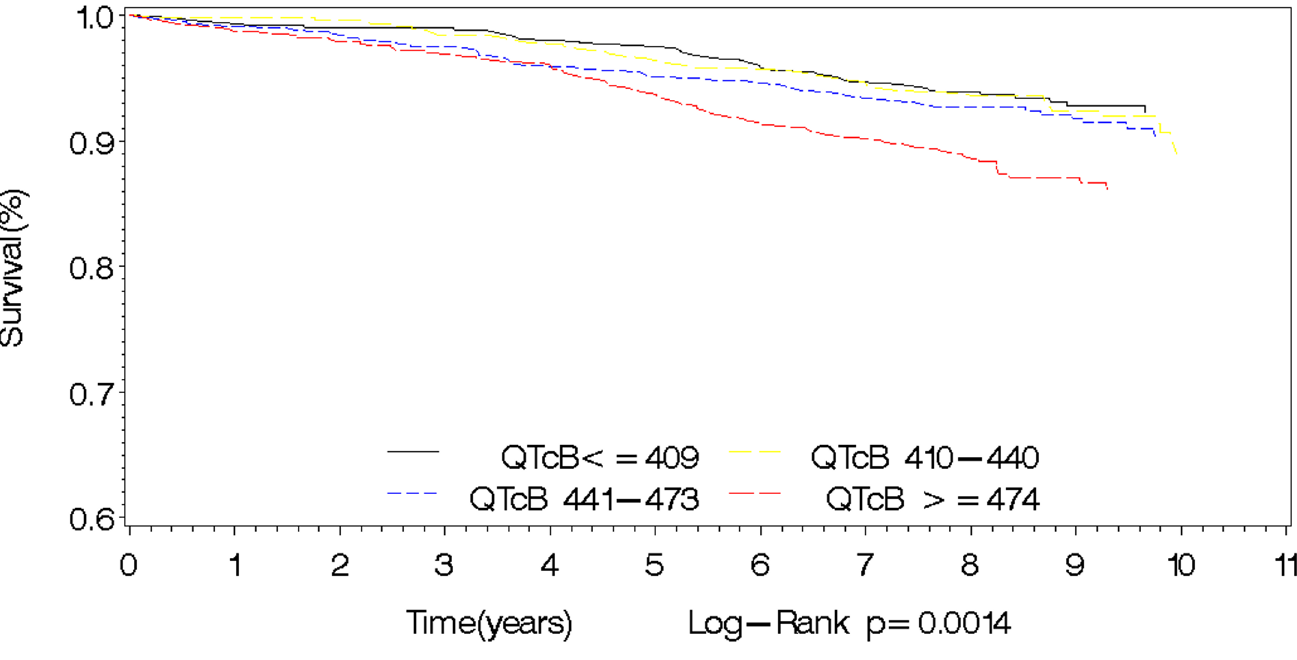
Fig 1. Kaplan Meier survival curves for mortality by QTcB